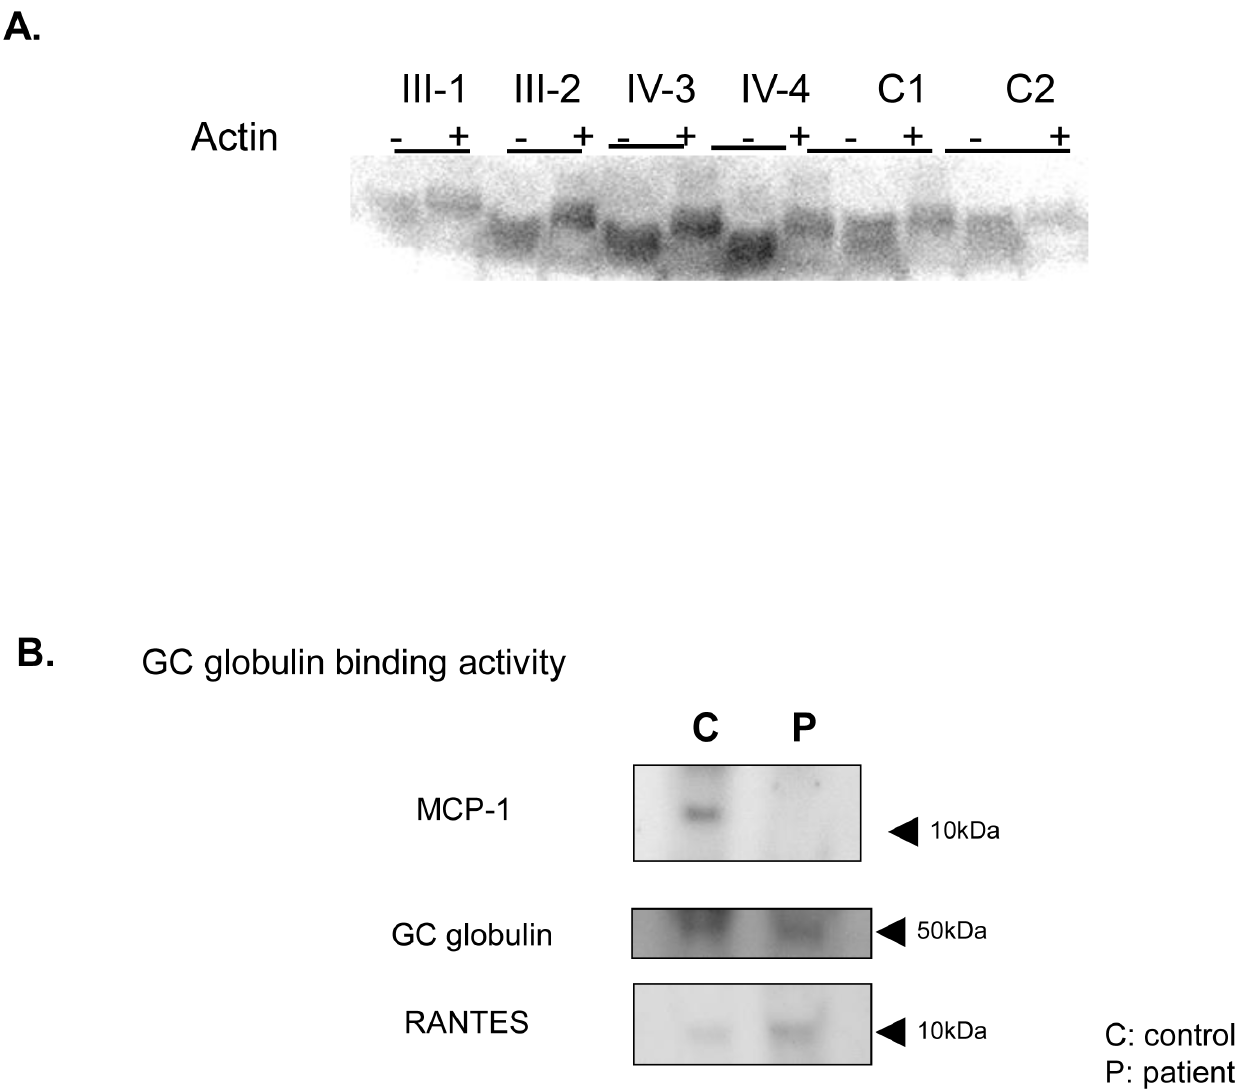
Figure 3. Actin binding activity and immunoprecipitation with GC globulin. A ) There was no difference in actin binding to GC globulin between the patients and the control subjects. When actin was added to the sample, the molecular weight of GC globulin increased + : sample with actin; -: sample without actin. B ) HEK 293 cells were transfected with plasmids containing a normal GC globulin sequence allele or a mutant GC globulin sequence allele tagged with GFP. Mutant GC globulin, which had the same mutation as that occurring in the patients, could not bind to MCP-1 but was able to bind to RANTES in the cell culture system.